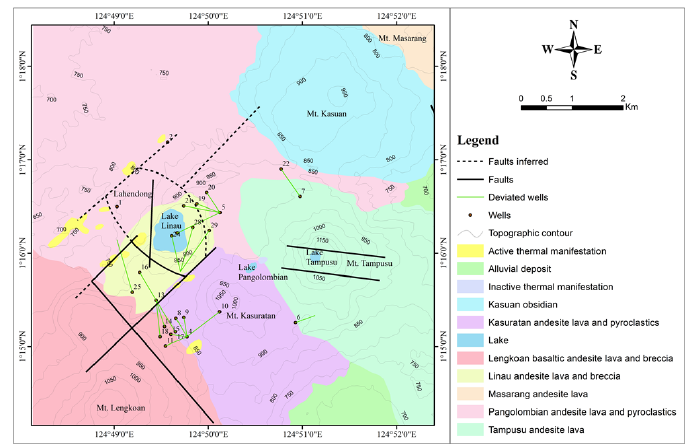
Figure 3. Geological and topographic map of Lahendong geothermal field [5,34].